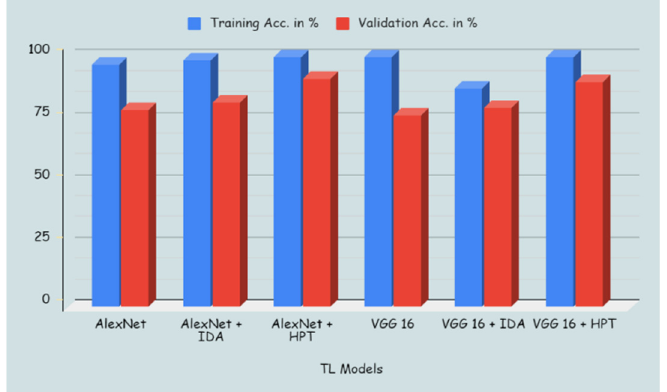
Figure 19. Transfer learning models’ training and validation accuracies.